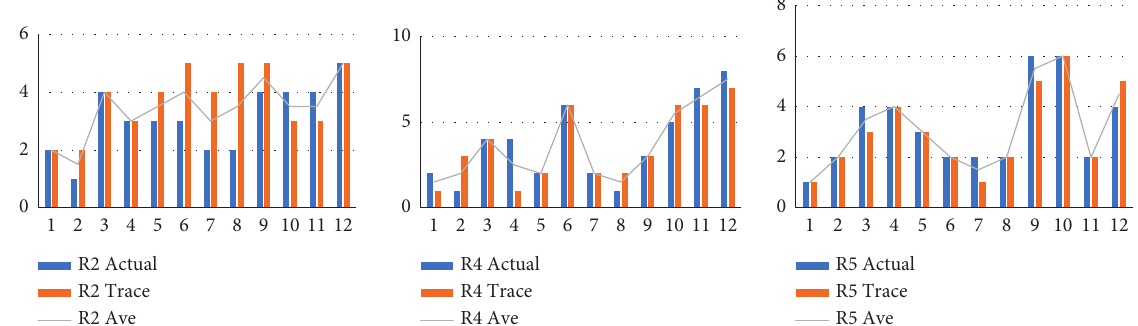
Figure 2: Chart of actual, trace, and average progressions of the pupils identified as irregular